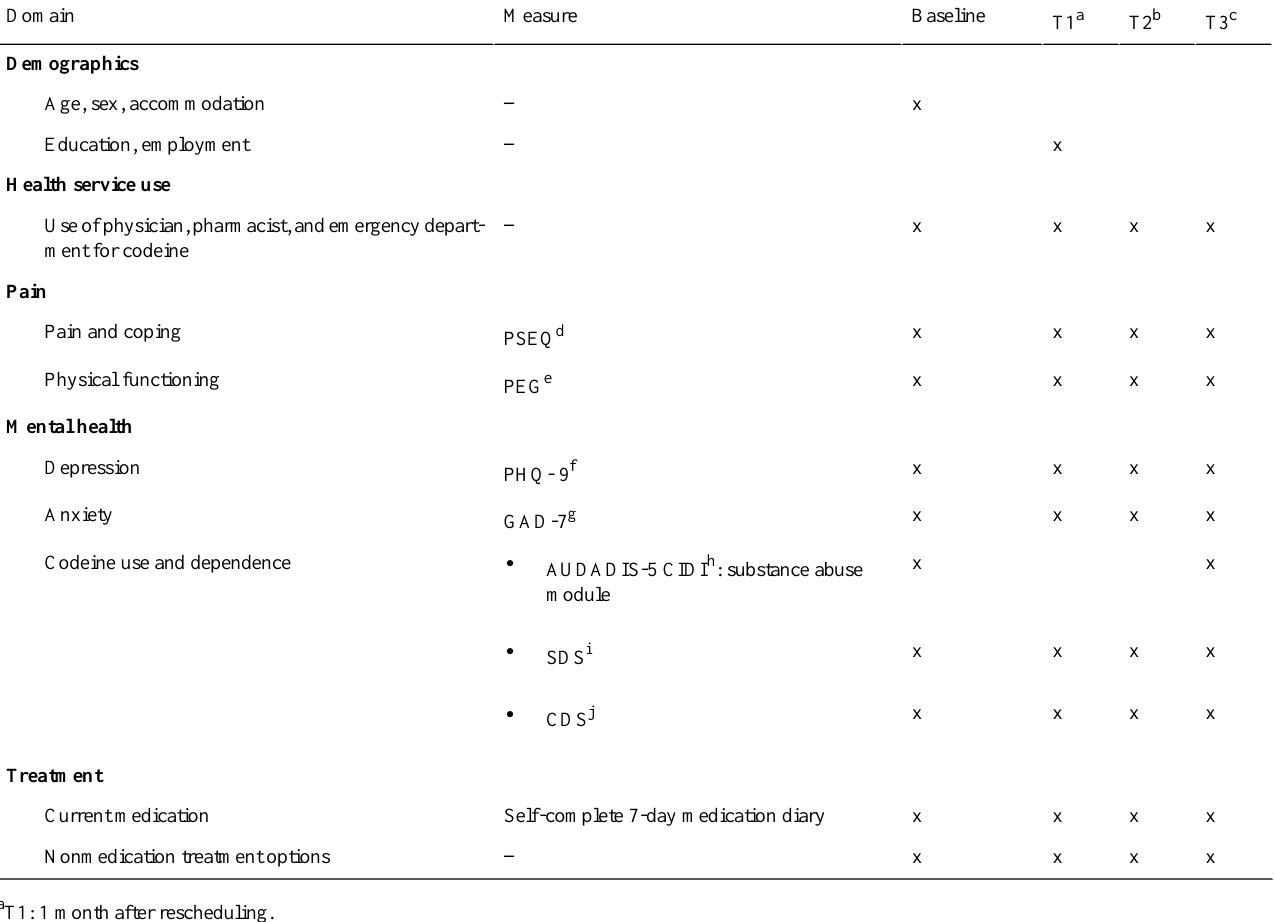
Table 1. Domains, measures, tools, and time points for data collection for the Codeine Cohort